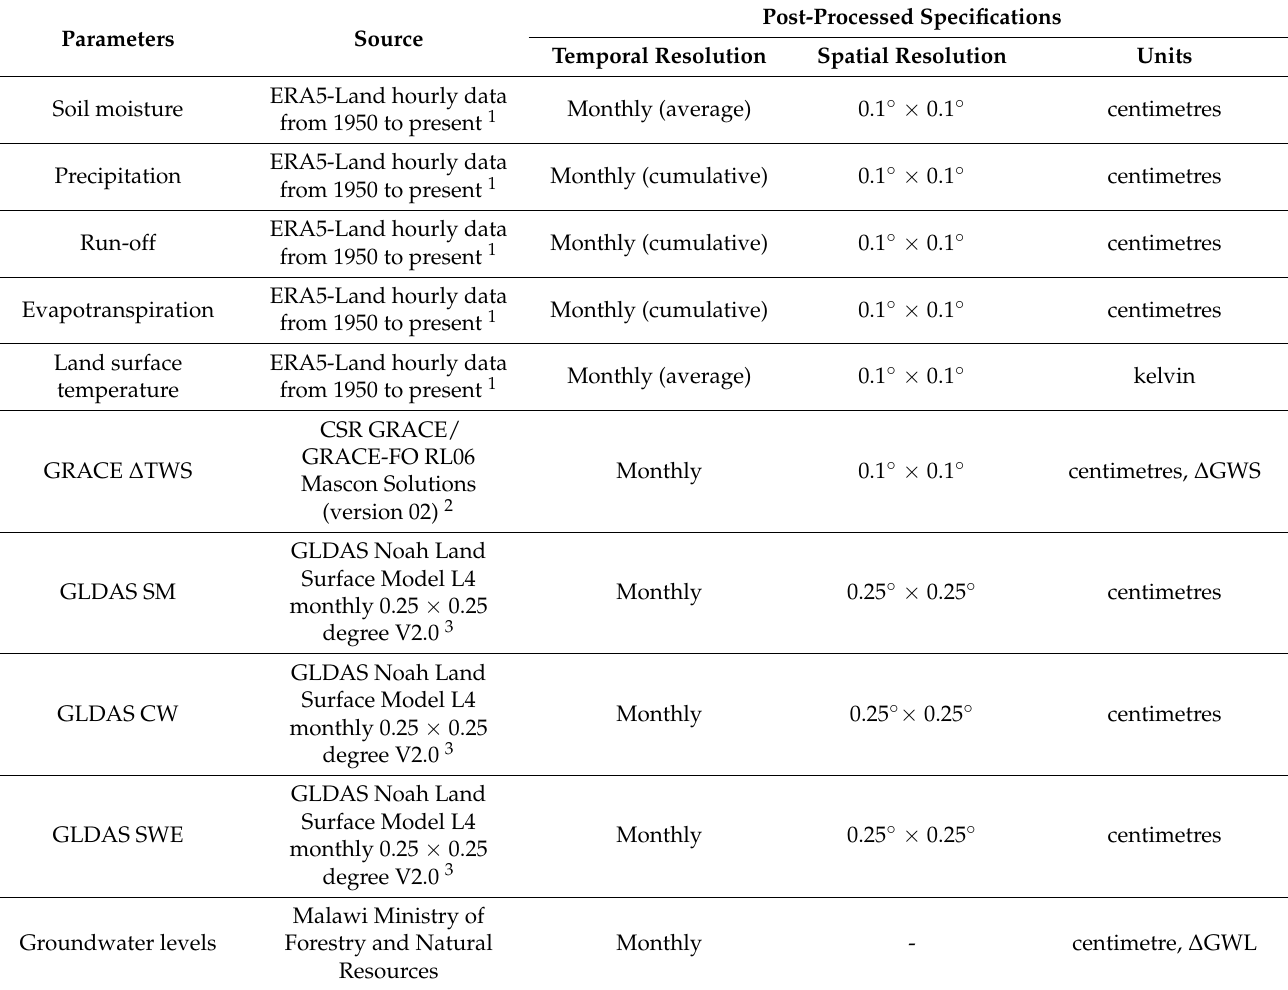
Table 1. Summary of the parameters data sources and their post-processing